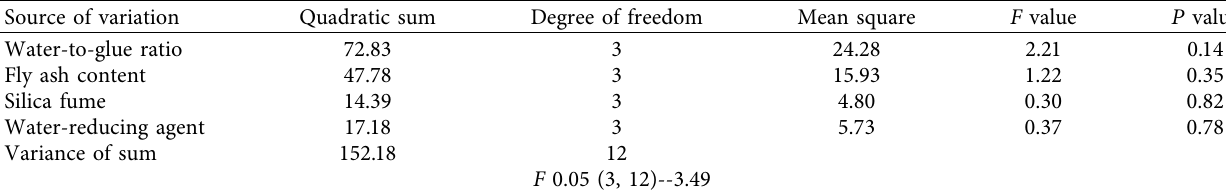
Table 7: Variance analysis of 14-day compressive strength of concrete.